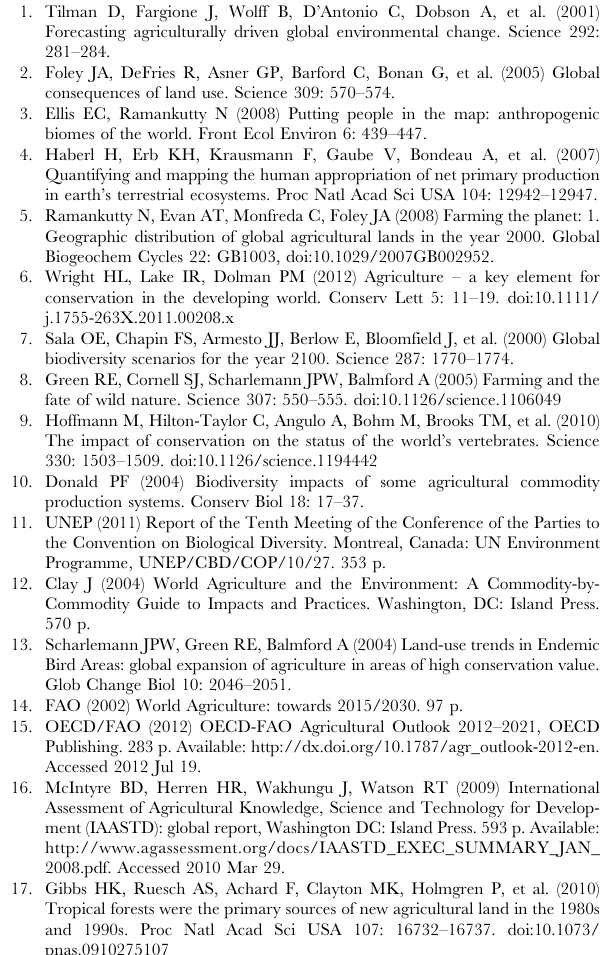
Table S2 Areas and changes in area of annual and data and land data, for the period 1999–2008, for 128 tropical countries. Increments are based on linear regression, and all areas are in km2. Countries are ordered by annual increment in total cropland. ‘‘NA’’ =not available. Table S3 Scientific names of crops mentioned in the text. Table S4 Sources of data used in this paper. With list